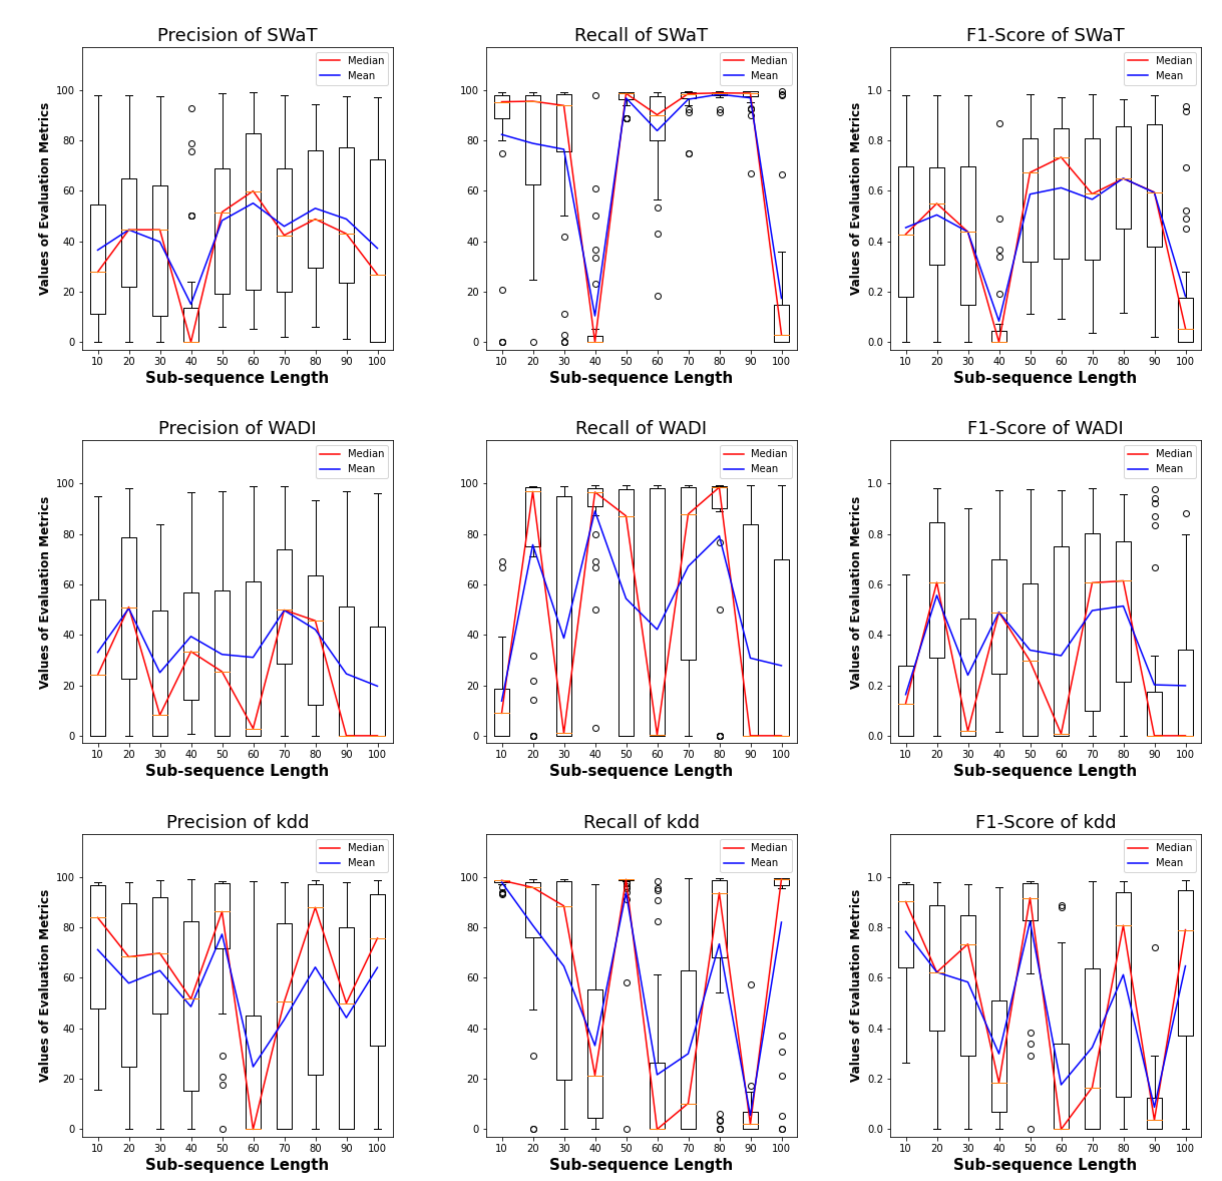
Figure 8. The variation of Precision , Recall , and F 1 with different sequence lengths in the represen- tative dataset, i.e., SWaT. The experiments are conducted with 100 iterations. The median values of each box are shown linked together with a red line, and the mean values of each box are shown linked together with a blue